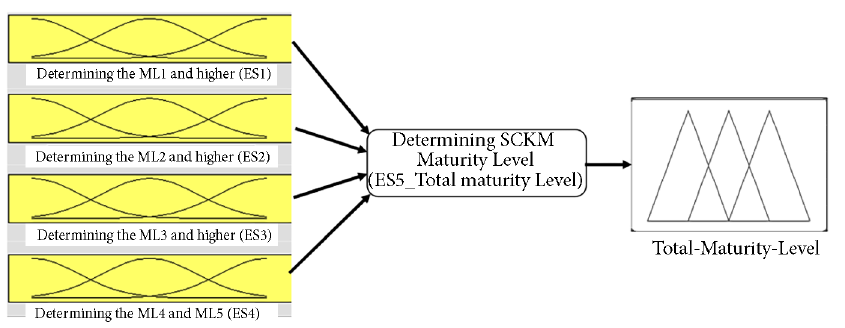
Figure 3. The schema for expert system of SCKM maturity